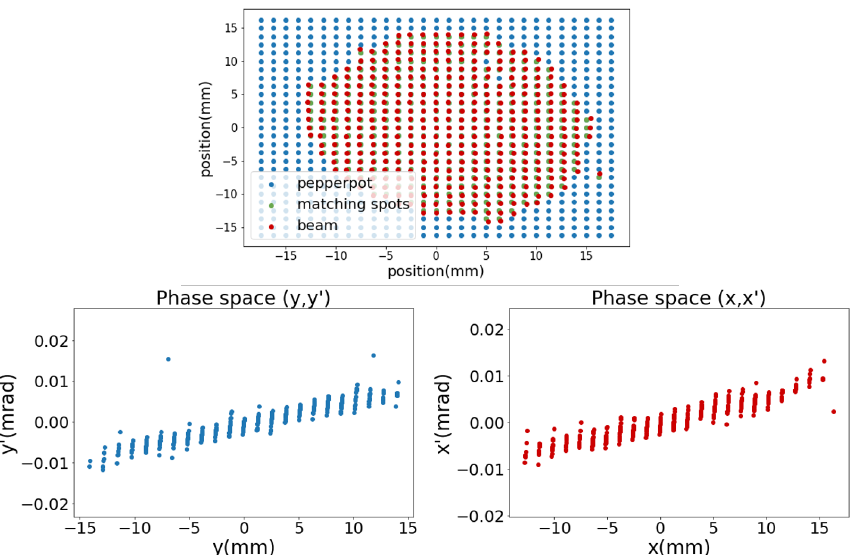
Figure 9. Beam emittance as measured with the pepperpot located in the central section of the